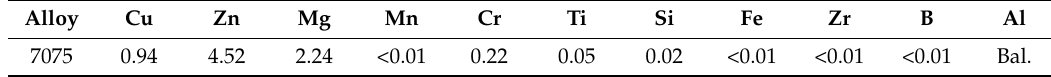
Table 1. Chemical composition of wrought 7075 Al alloy (wt %)